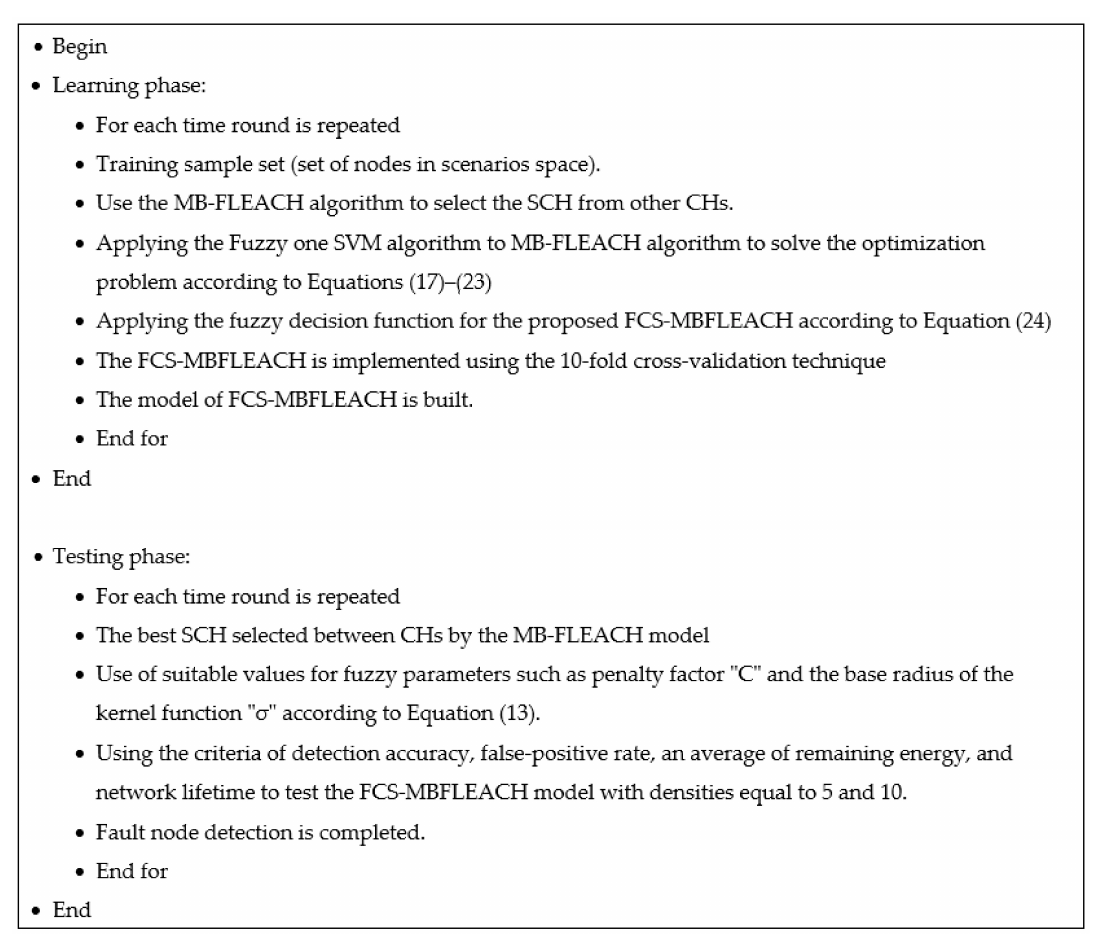
Figure 4. The proposed FCS-MBFLEACH